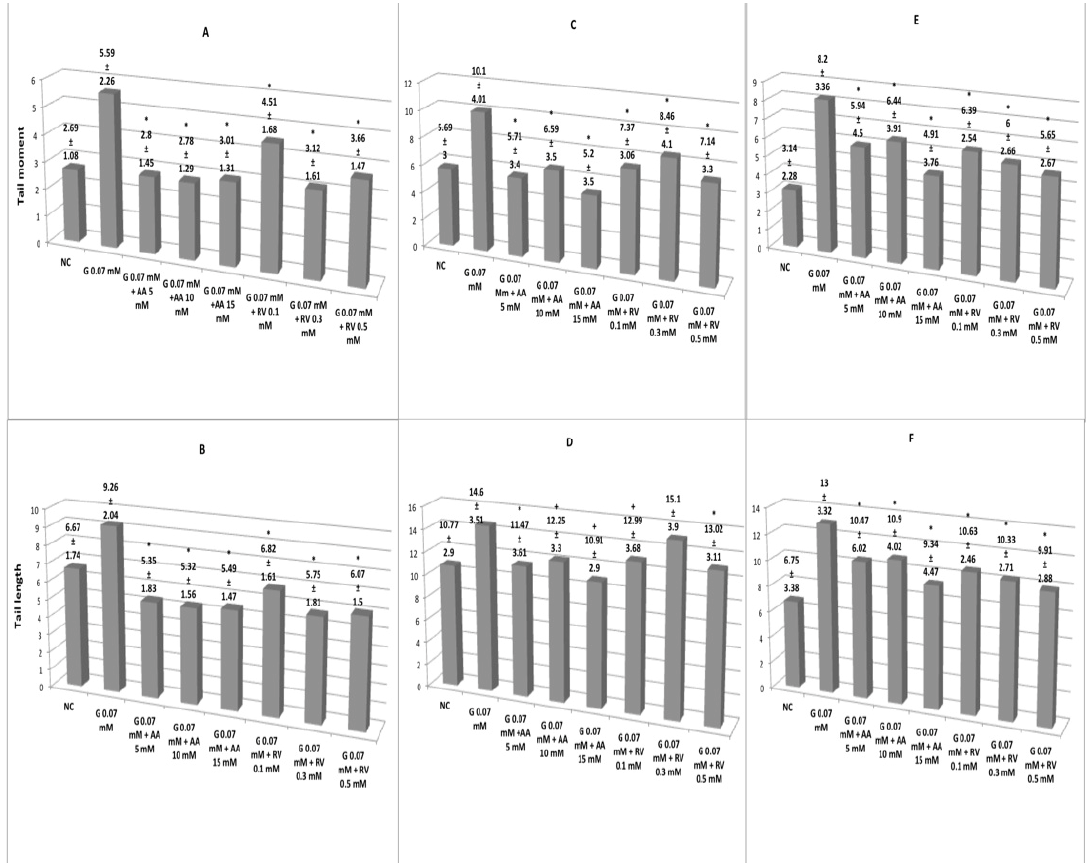
Figure 3. Tail moment and tail length in erythrocytes of Oreochromis niloticus ( A , B ) and Ambystoma mexicanum ( C , D ) and human lymphocytes ( E , F ) exposed to AA or RV simultaneously to 0.07 mM G exposure. Except for the concentration G 0.07 mM + RV 0.03 mM ( D ), all the experimental groups are significantly different ( p < 0.05) from G 0.07 mM, using both parameters in the three organisms studied. * Significant difference ( p < 0.05) with respect to G